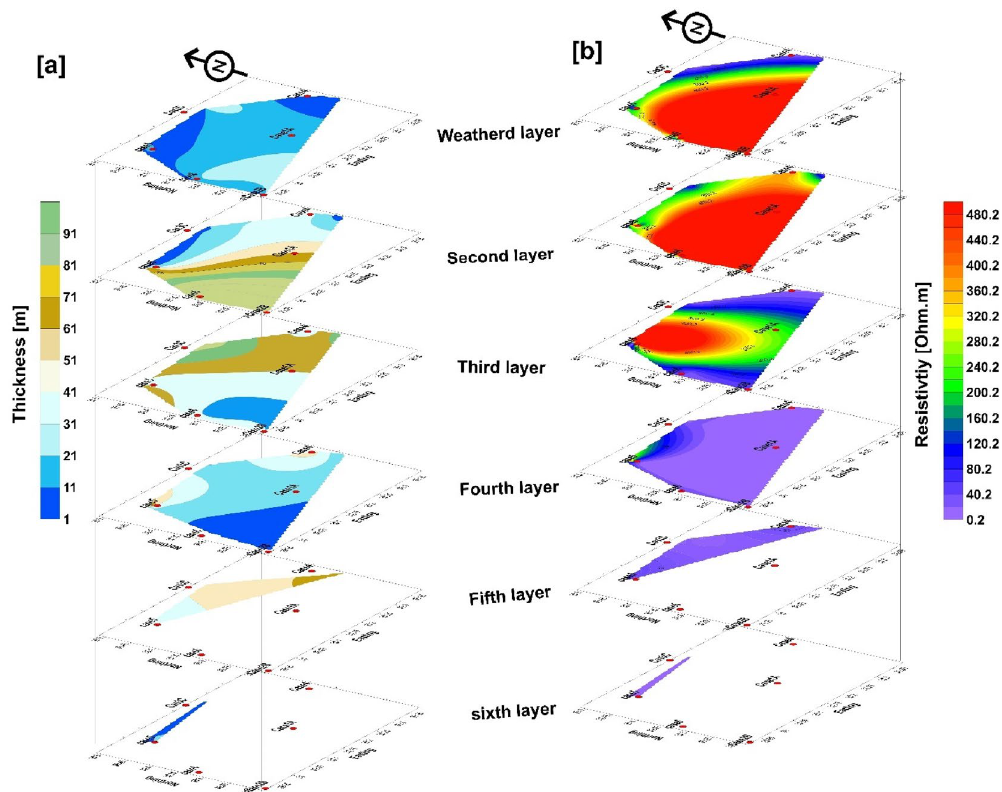
Figure 11. 3D view contour maps. ( a ) Isopach map in (m), ( b ) Iso resistivity map in Ohm m for the all-case